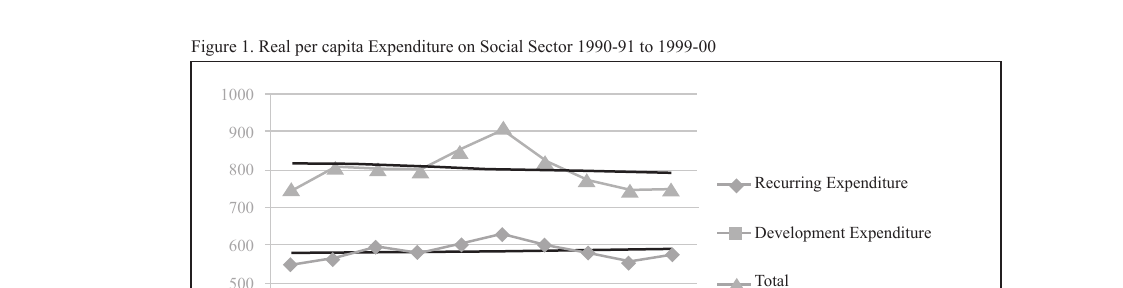
Figure 1. Real per capita Expenditure on Social Sector 1990-91 to